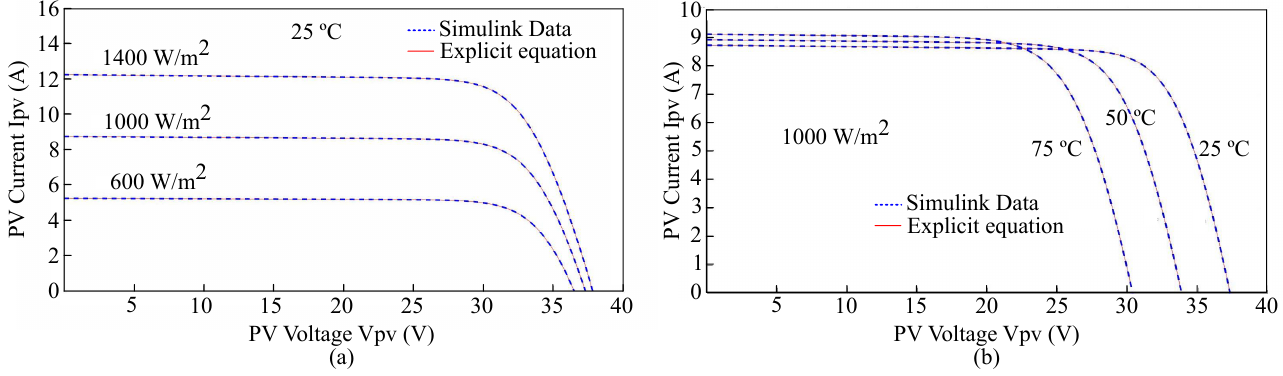
Figure 2. I-V characteristic calculated by explicit equation and Simulink: ( a ) Static characteristics with variations of irradiance, and ( b ) static characteristics with variations of